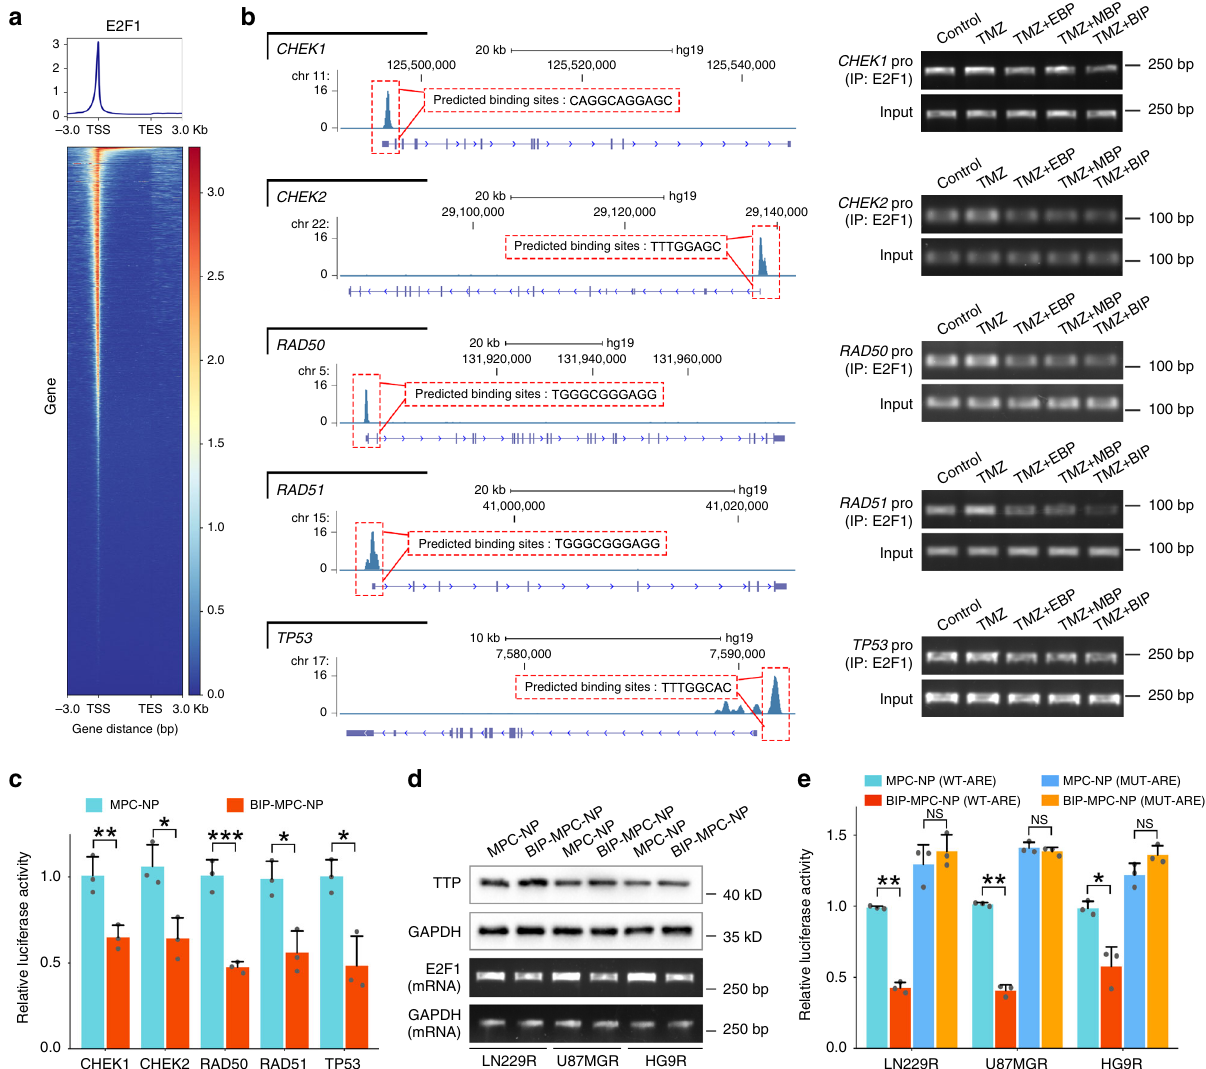
Fig. 5 BIP-MPC-NP restrains E2F1-mediated DNA damage repair modules via the inhibitory effect of TTP. a E2F1 binding sites within a region spanning ± 3 kb around TSS in the whole genome. b The signal peaks located in the promoter regions of CHEK1 , CHEK2 , RAD50 , RAD51 and TP53 in E2F1 ChIP-seq data and the binding sites of E2F1 were predicted on JASPAR datasets. The agarose gel electrophoresis displayed the enrichments of E2F1 in the promoter regions of CHEK1 , CHEK2 , RAD50 , RAD51 and TP53 of LN229R. c The luciferase reporter assay displayed the E2F1 transcriptional activity in the promoter regions of CHEK1 , CHEK2 , RAD50 , RAD51 and TP53 in LN229R ( n = 3). d The TTP protein expression and E2F1 mRNA expression in LN229R, U87MGR and HG9R treated with MPC-NP or BIP-MPC-NP. e The inhibitory effect of TTP on wild-type or mutant-type ARE motifs within the E2F1 mRNA 3 ′ -UTR in LN229R cells with MPC-NP or BIP-MPC-NP treatments ( n = 3). The error bars in c and e represent the S.D. of three measurements. P value is determined by Student ’ s t -test. Signi fi cant results are presented as NS non-signi fi cant, * P < 0.05, ** P < 0.01, *** P <